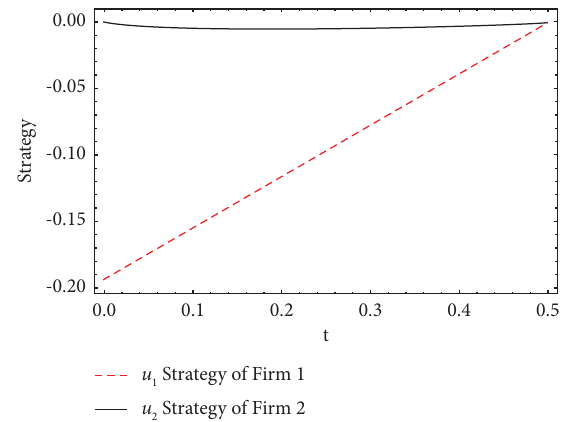
Figure 2: Te advertising eforts of frm 1 and frm 2 at the time t